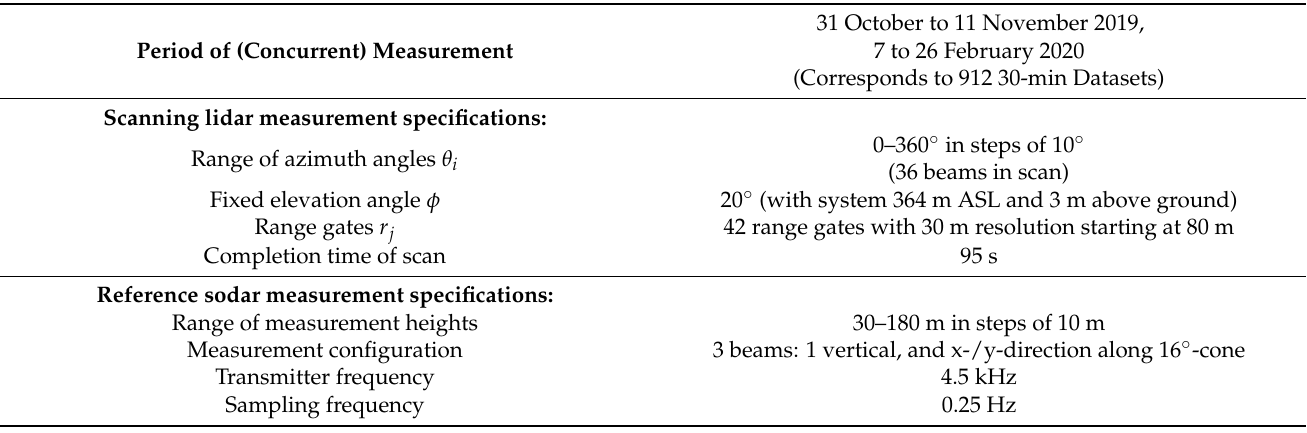
Table 2. Specifications of measurement campaign for scanning lidar and reference sodar measurements.